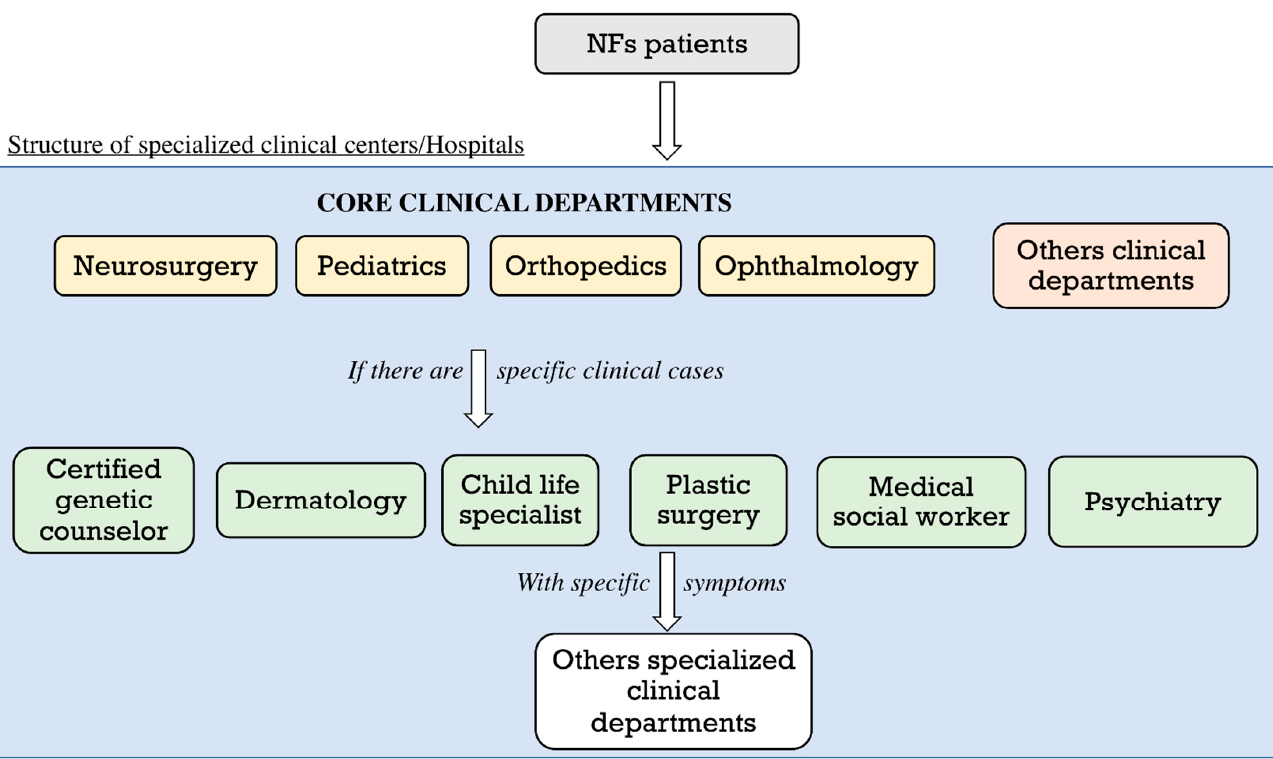
Figure 2. Clinical course of NFs patients. The figure illustrates the clinical path of NFs patients, also summarizing the specialist subdivision of the clinical centers.